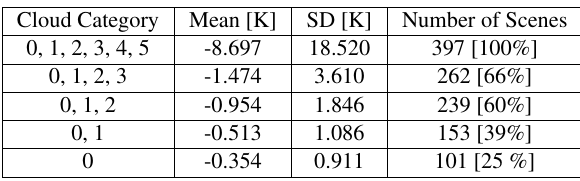
Table 5: Categories used in cloud analysis and breakdown of the number of scenes in each category for subset of scenes processed using MERRA dataset. metric band are shown in Table 6.